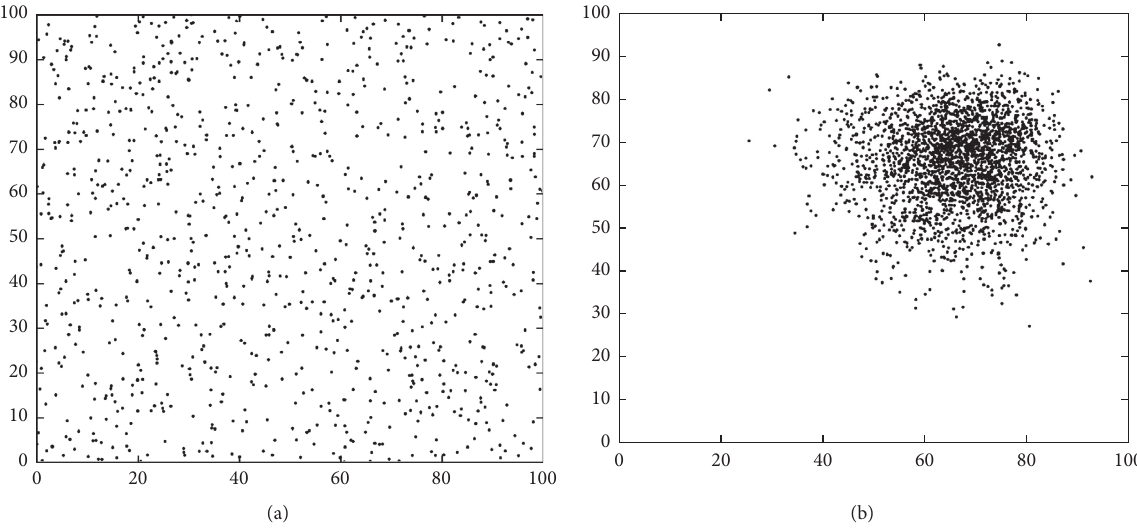
Figure 3: Two-dimensional diagrams of the (a) uniform and (b) Weibull distributions of microcracks inside a